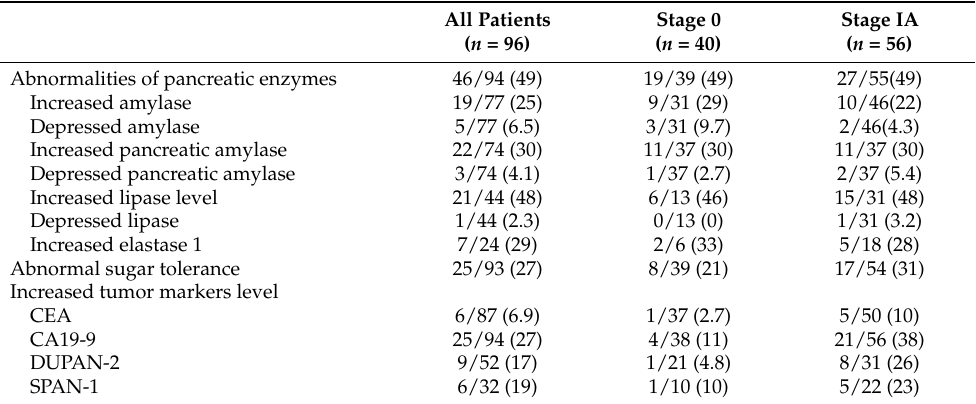
Table 3. Blood tests in patients with stage 0 and IA